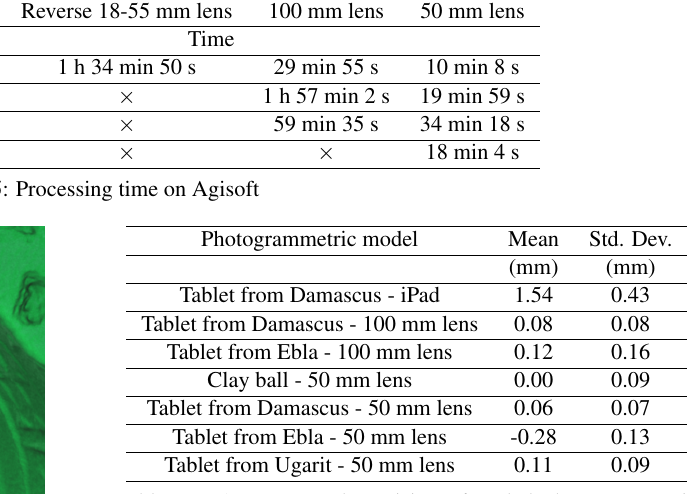
Table 7: Accuracy and precision of scaled photogrammetric